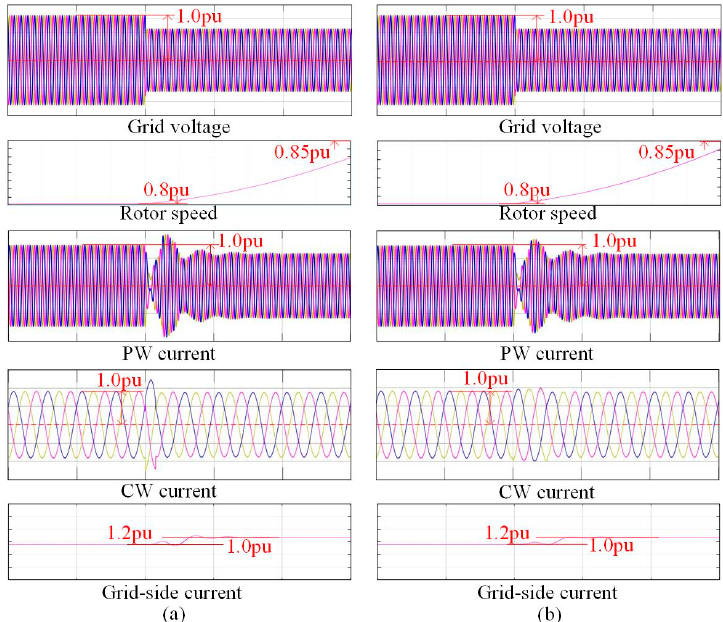
Figure 7. Comparisons of waveforms when the grid has a 30% voltage drop with ( a ) existing VSC and ( b ) the proposed VSC ( t : 0.2 s/div).